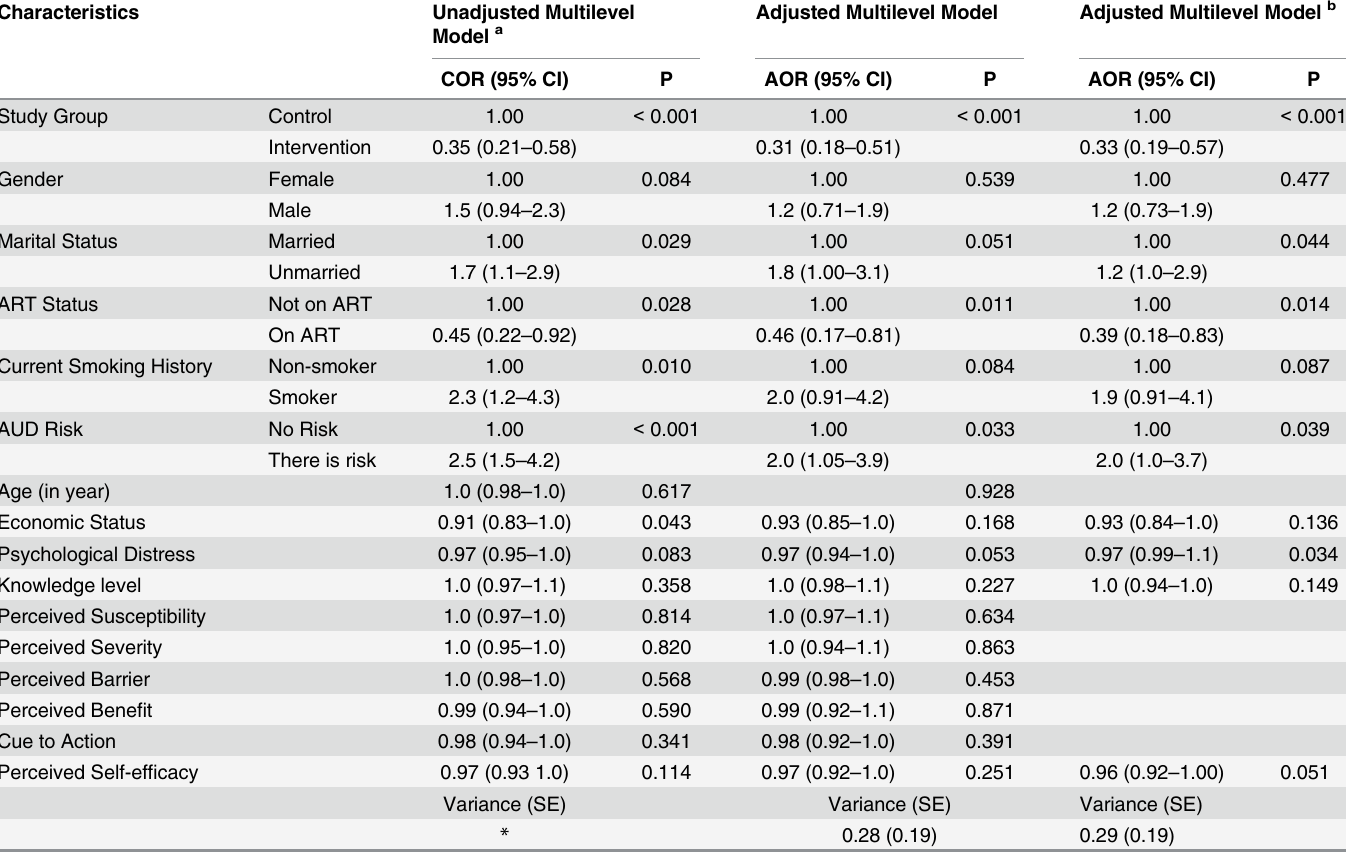
Table 3. Crude and Adjusted Odds Ratios of Predictors of TB Treatment Non-adherence.